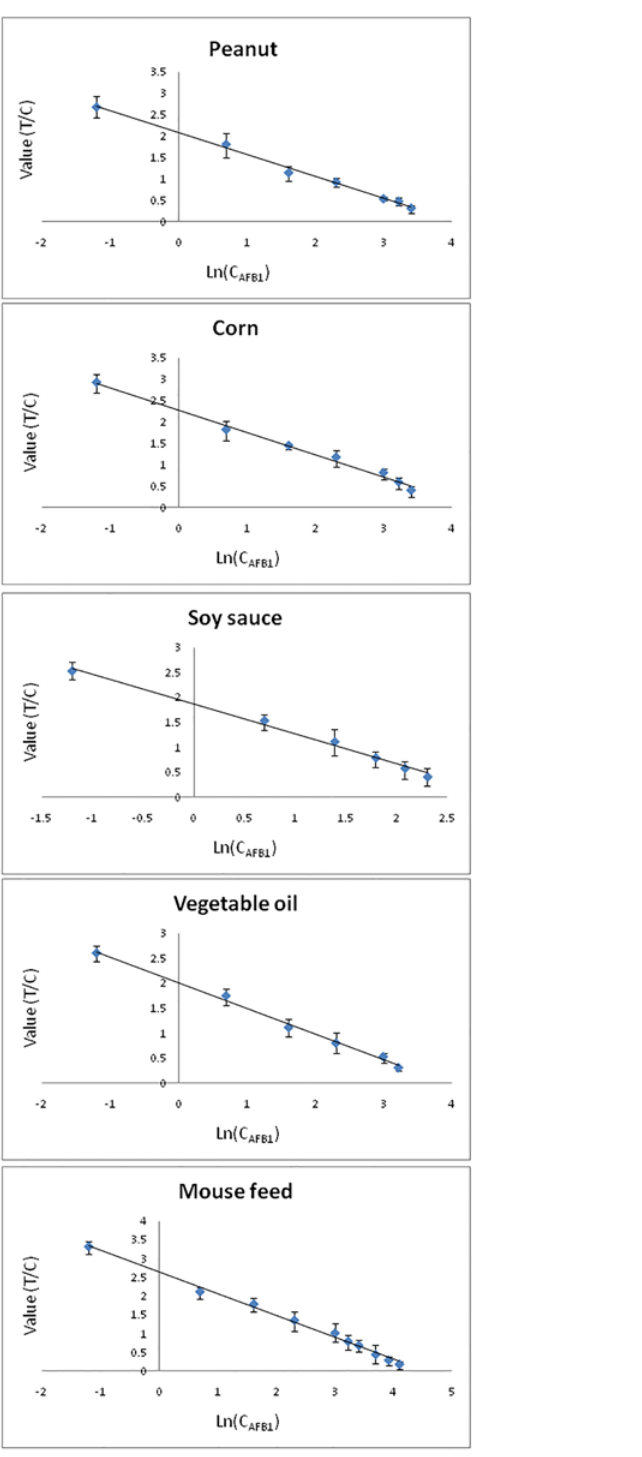
Fig 3. Standard curves for AFB 1 detection using CTRFIA.